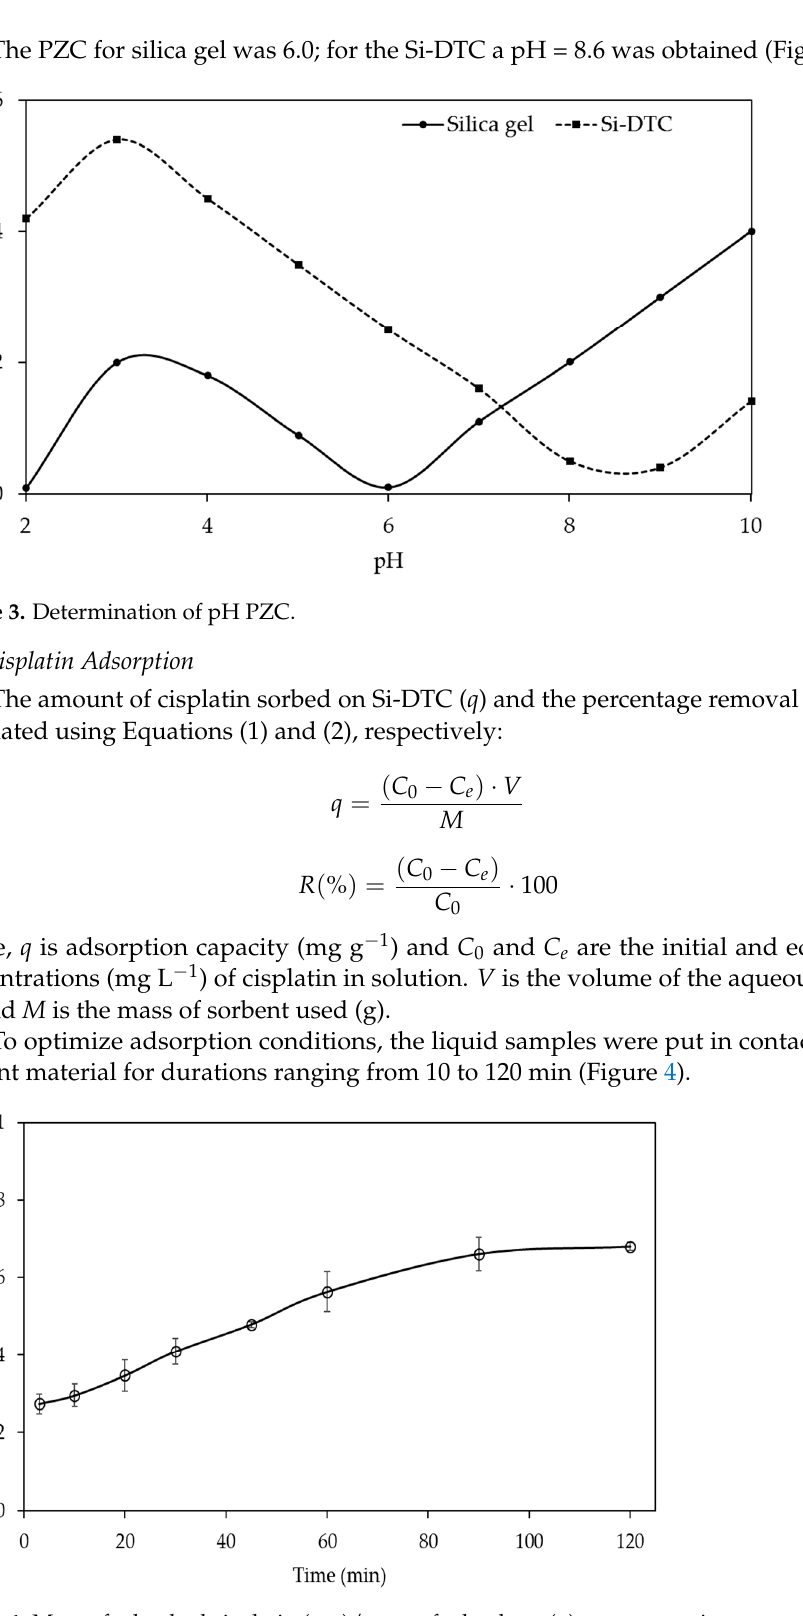
Figure 2. TGA curves of: (red) silica gel, (green) SiO 2 -NH 2 , and (blue) Si-DTC. The PZC for silica gel was 6.0; for the Si-DTC a pH = 8.6 was obtained (Figure 3).